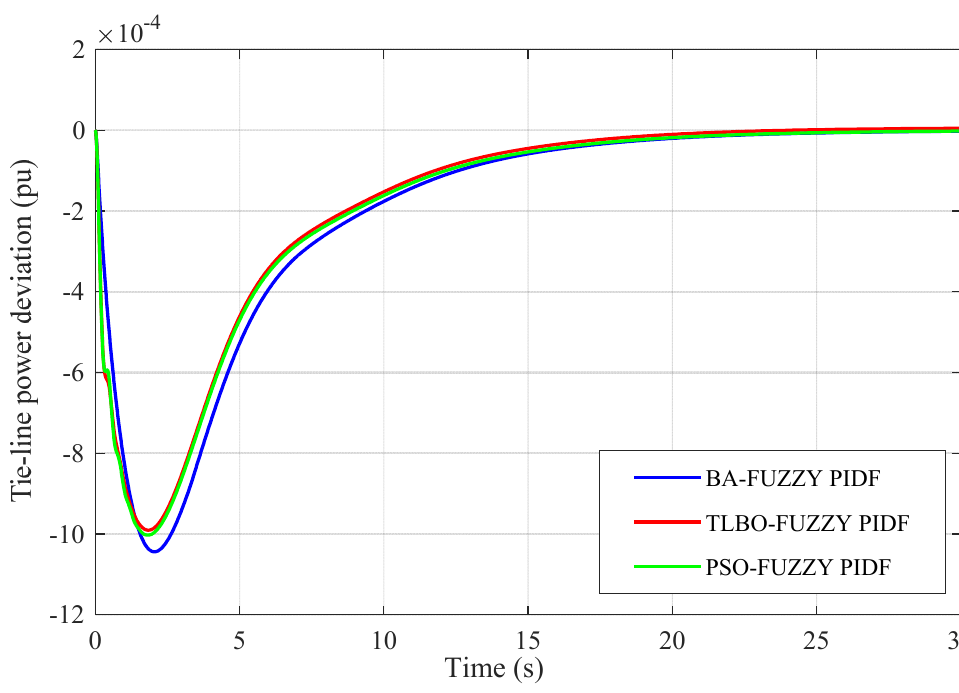
Figure 19. Frequency deviation in area 2 ( ∆ F 2 ).